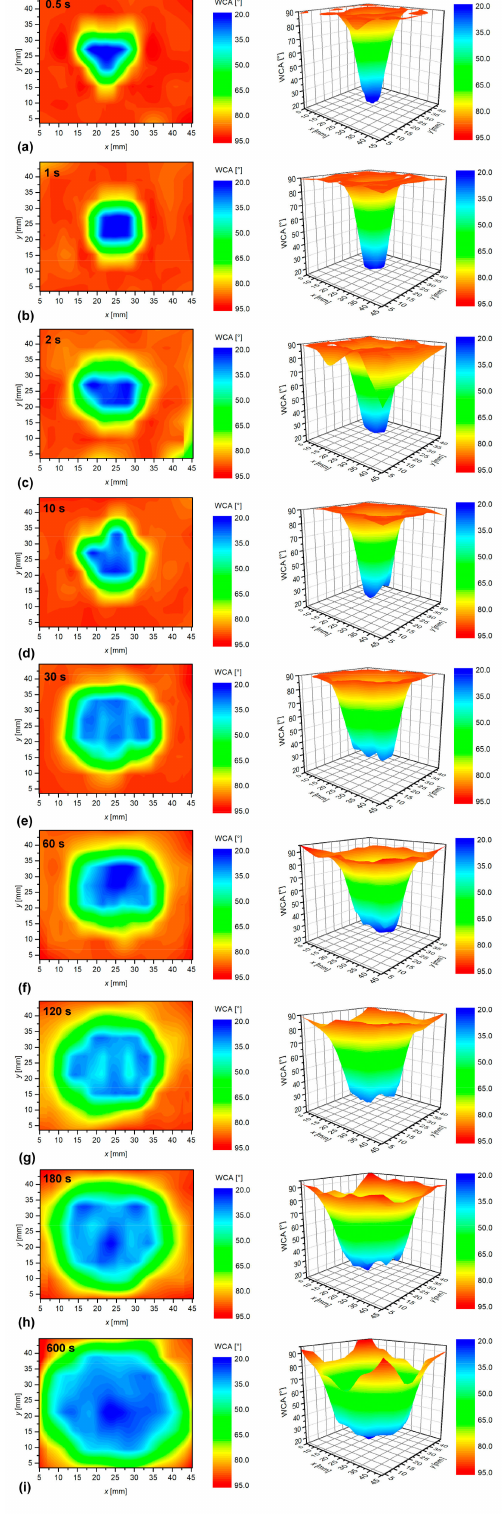
Figure 9. Evolution of the surface wettability for polystyrene treated at various treatment times for the sample distances of 5 mm from the APPJ nozzle: ( a ) 0.5 s, ( b ) 1 s, ( c ) 2 s, ( d ) 10 s, ( e ) 30 s, ( f ) 60 s, ( g ) 120 s, ( h ) 180 s, ( i ) 600